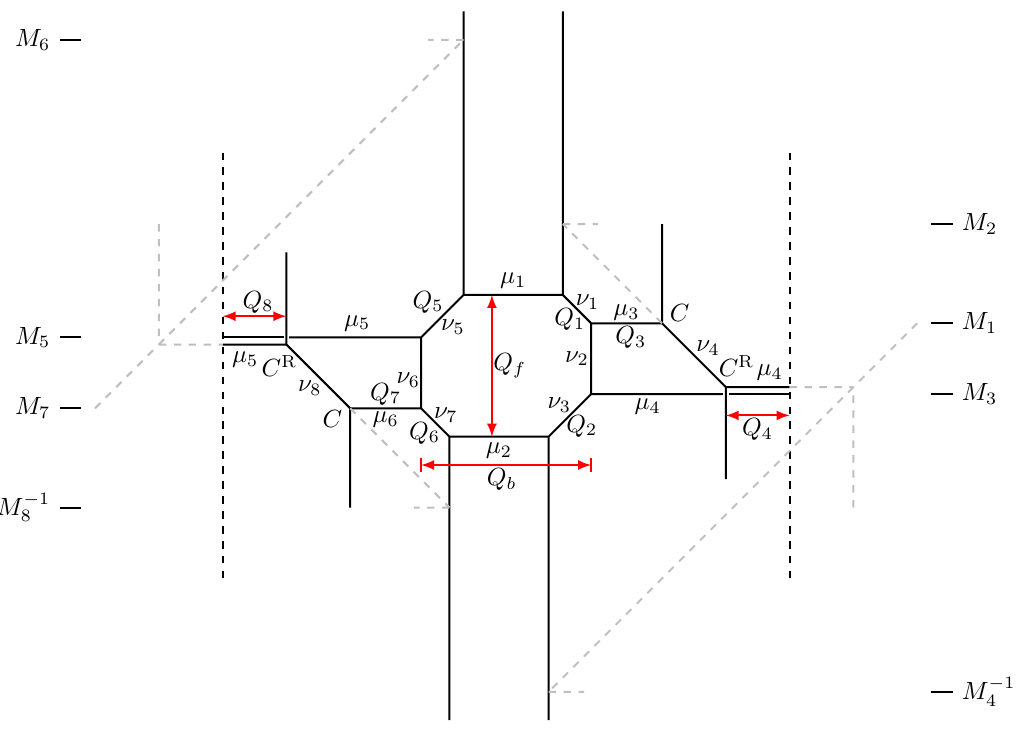
Figure 15 . A 5-brane web for E-string theory on a circle as affine D 4